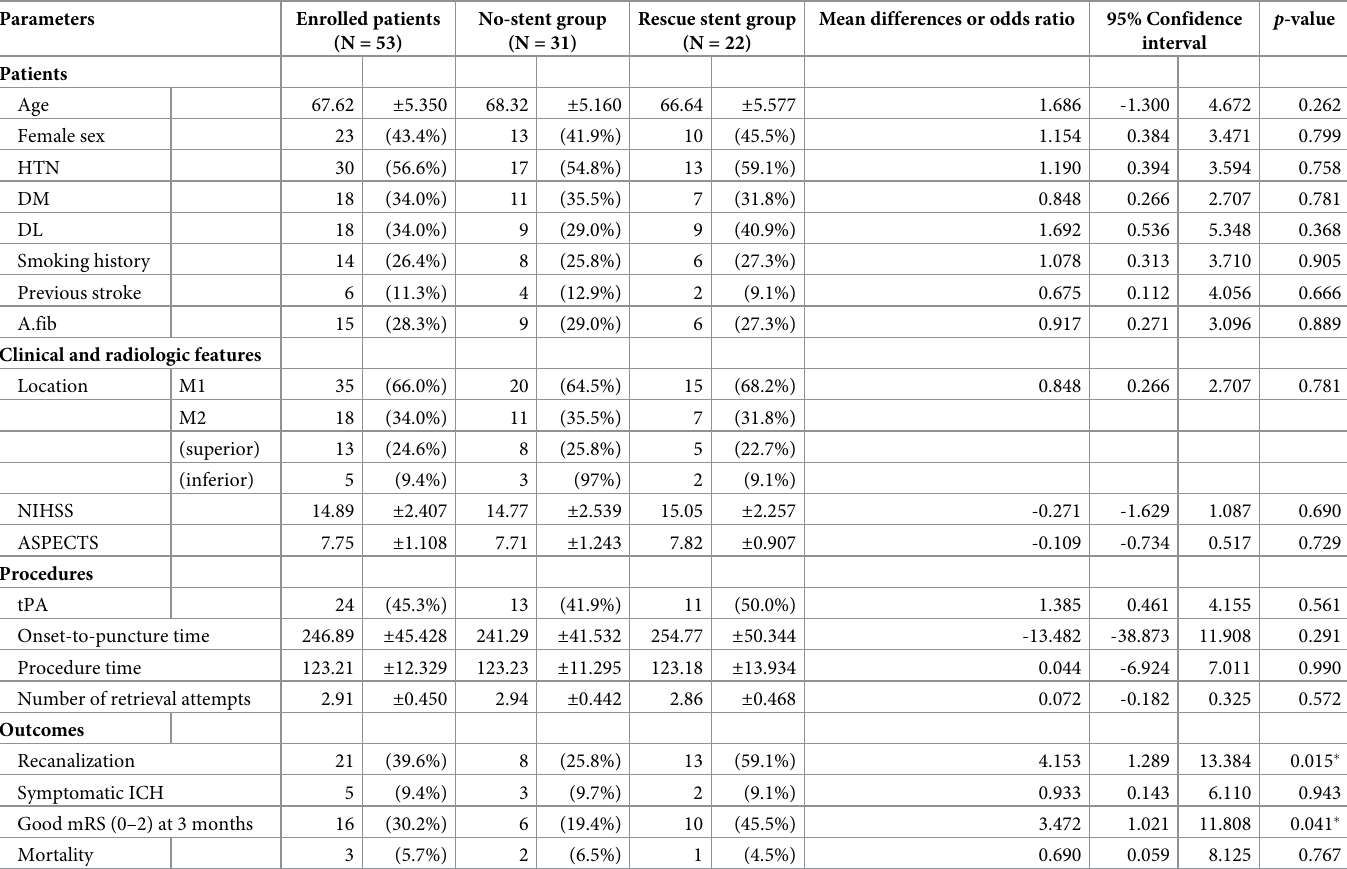
Table 1. Results of comparative analysis between the rescue stent and no-stent groups.